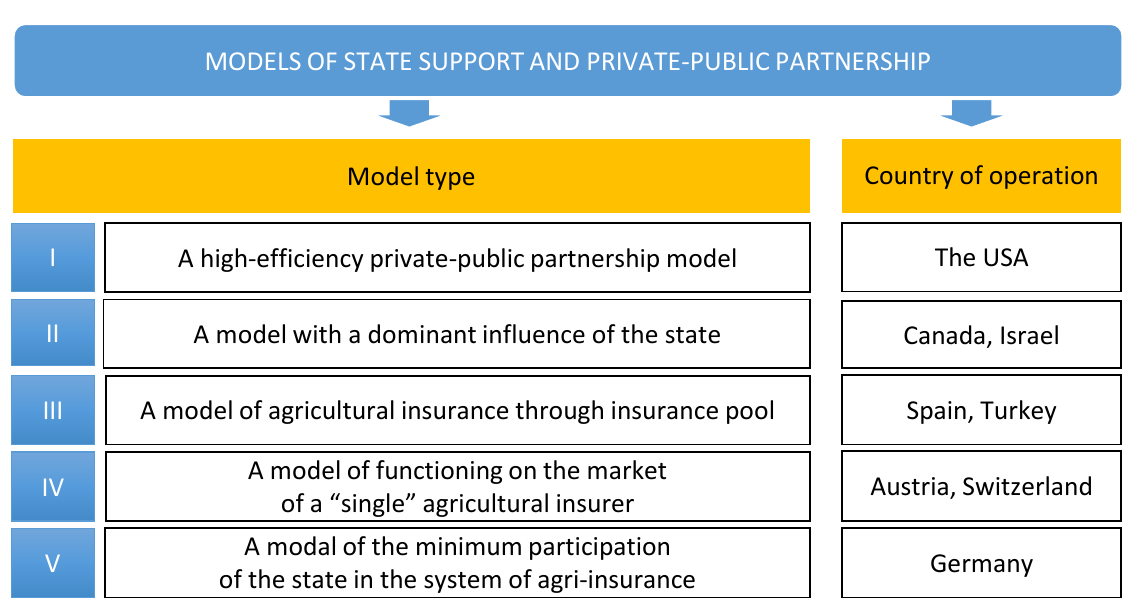
Figure 10. Models of state regulation